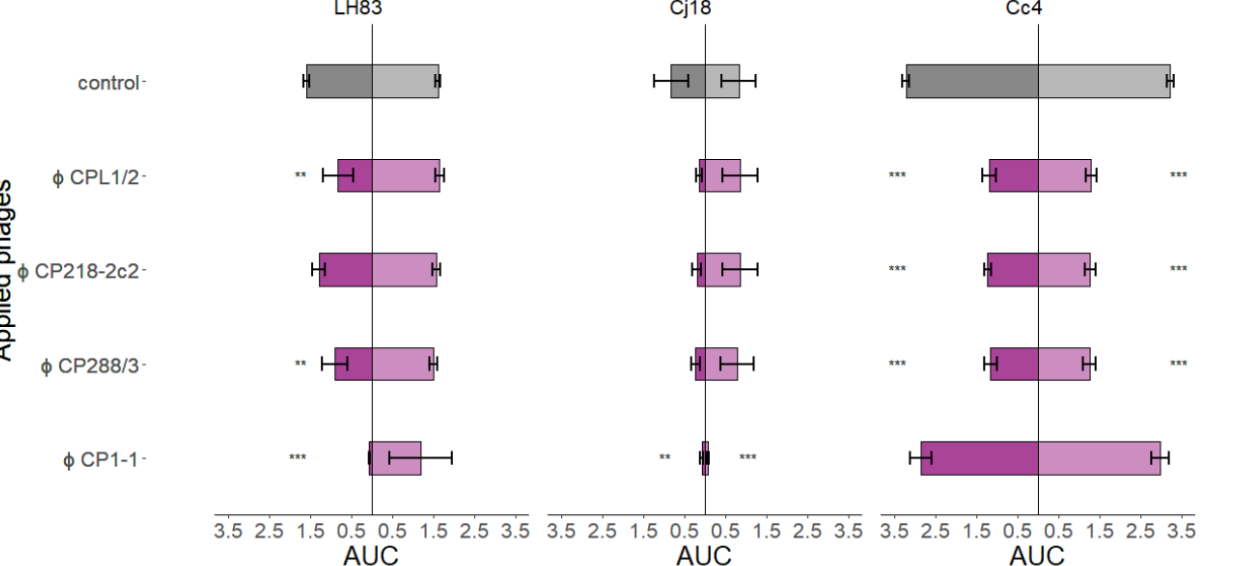
Table 4. Mean phage concentrations (c 0 ) at the beginning of single-phage planktonic killing assays (log 10 (PFU/mL)) .